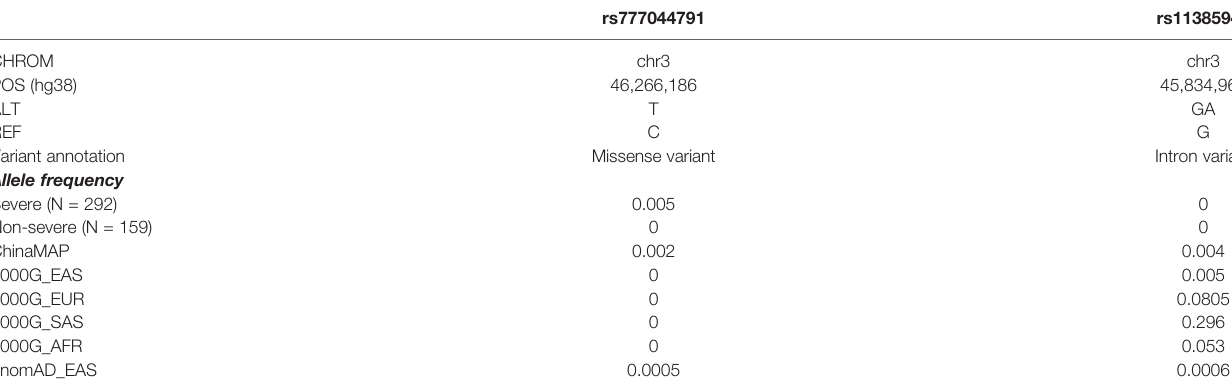
TABLE 3 | The comparison of allele frequency for two